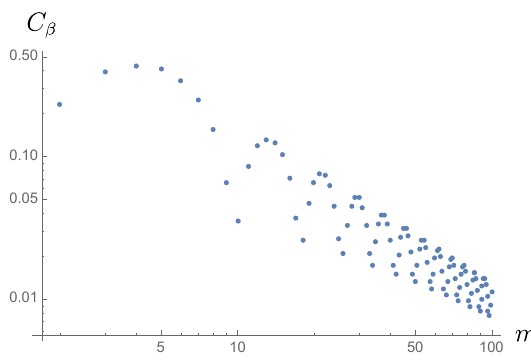
Figure 6 . The absolute value of the late-time value of the OTOC for the unitary minimal models ( m; m + 1) is shown according to (3.32). The OTOC asymptotes to zero as an oscillating power M law ( m (cid:0) 1 ) at large m , showing enhanced scrambling.